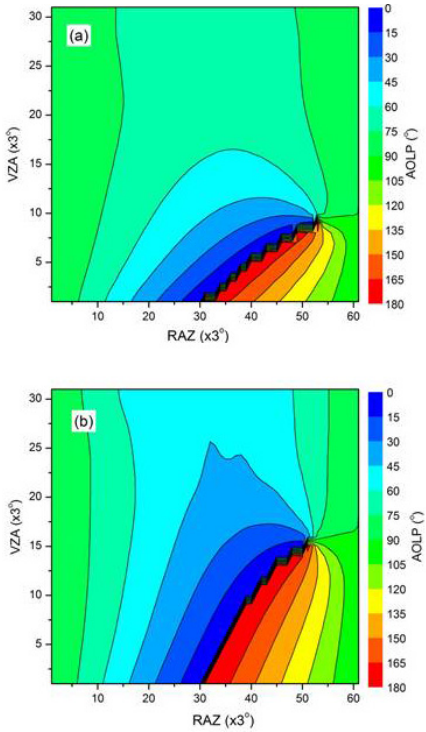
Fig. 6. Same as in Fig. 4, but for the AOLP from the ADRTM. The solar zenith angle (SZA) for (a) is 23.44 ◦ and for (b) is 43.16 ◦